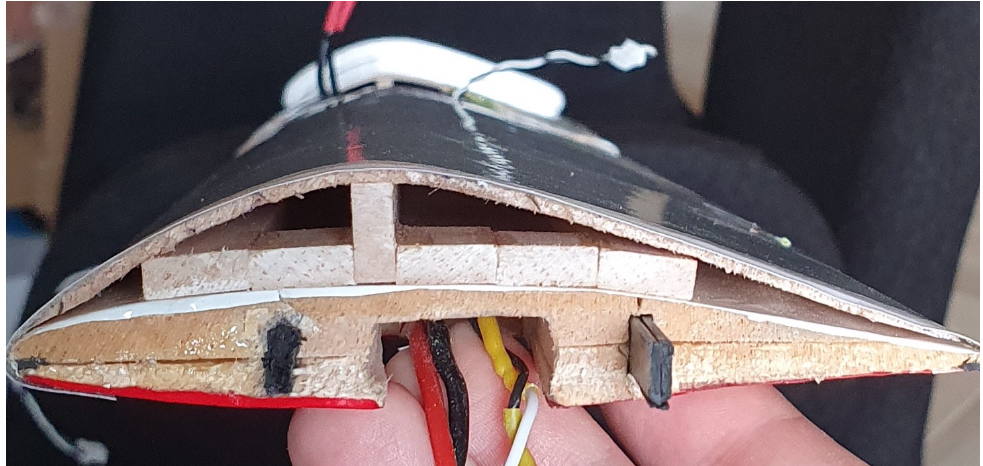
Figure 11. An actual final wing airfoil—the original P-51D tip (BL215) airfoil is still visible underneath an extra top wing surface. The original wing was full-balsa construction, while the modification was based on a few balsa wood strips and a 1.5 mm-thick balsa wood